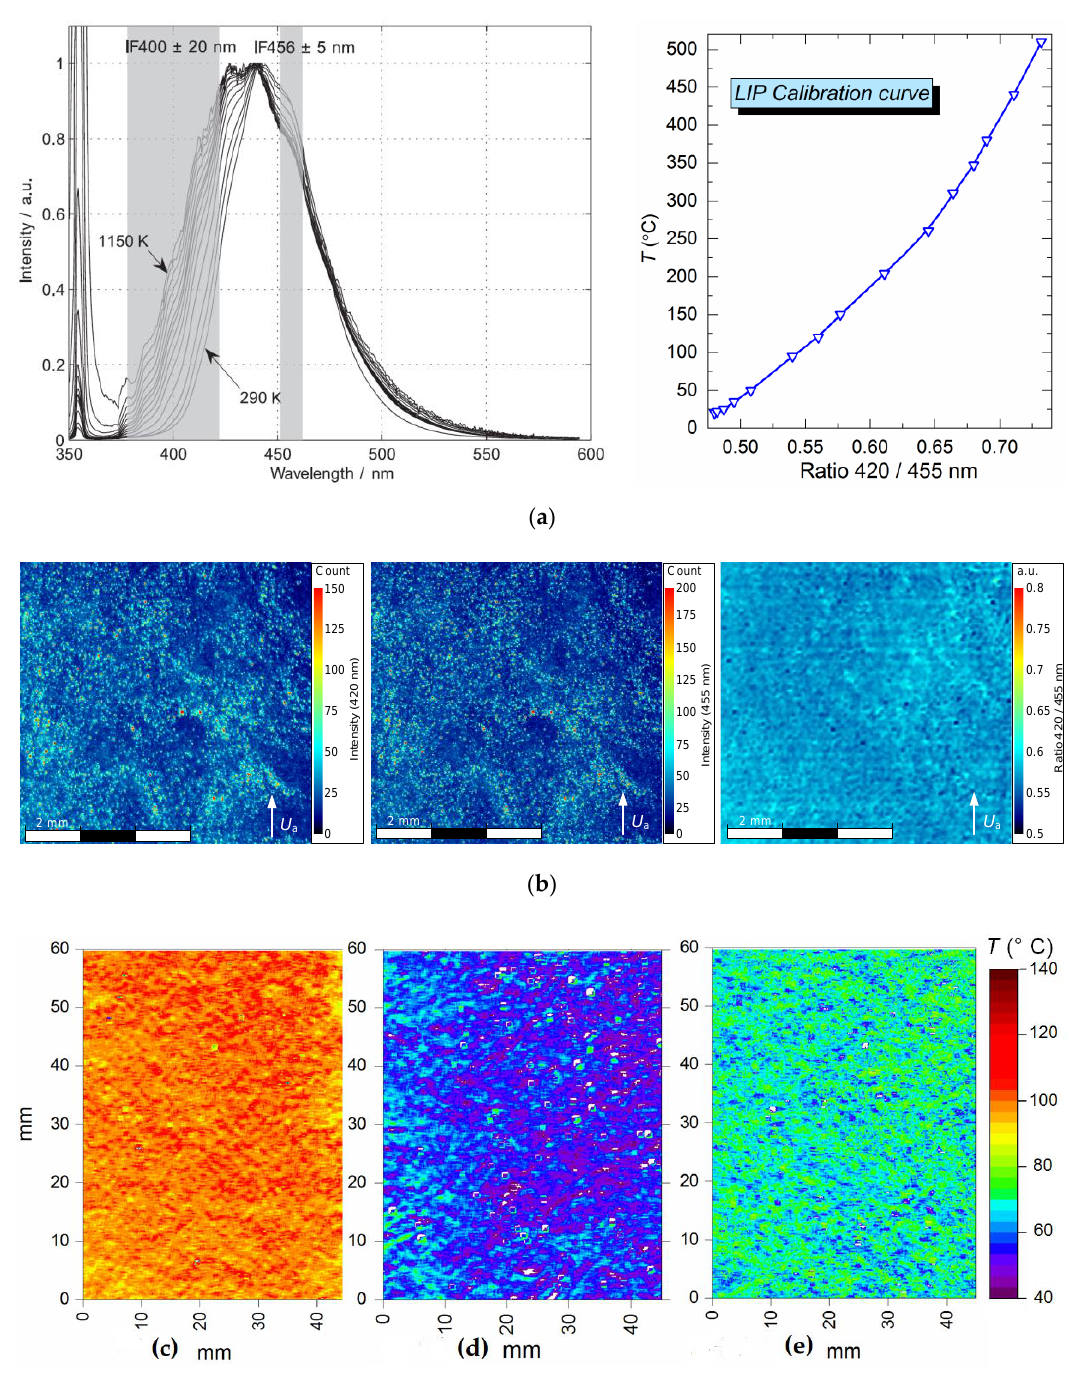
Figure 3. The emission (left) spectrum [26] and calibration (right) curve ( a ); video frame of BAM:Eu particles before being processed ( b ); typical airflow temperature field without droplets ( c ), air flow ( d ) and combustion products flow ( e ) after droplets pass-through obtained by Laser-Induced Phosphorescence (LIP) technique (for T a ≈ 200 °C).